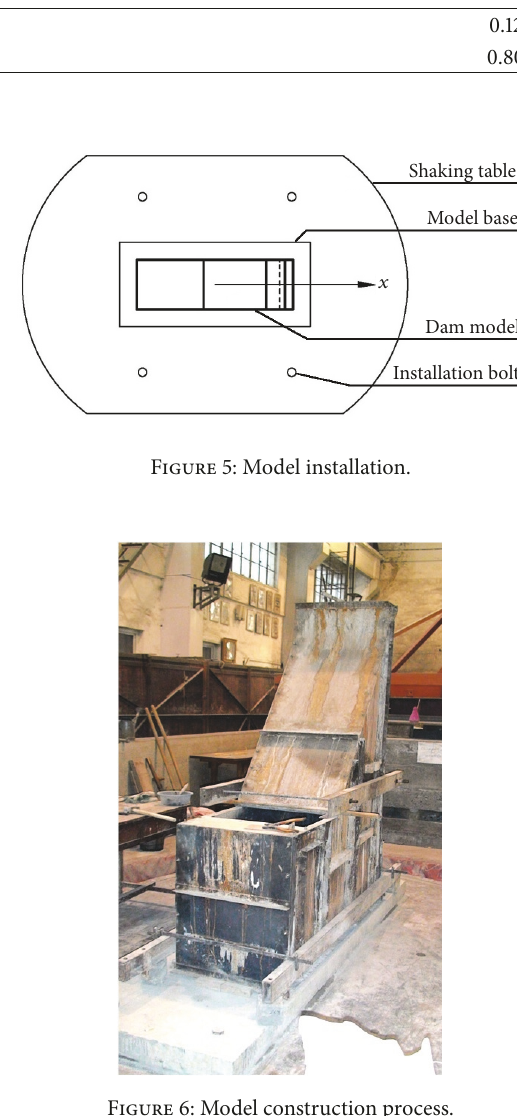
Figure 6: Model construction